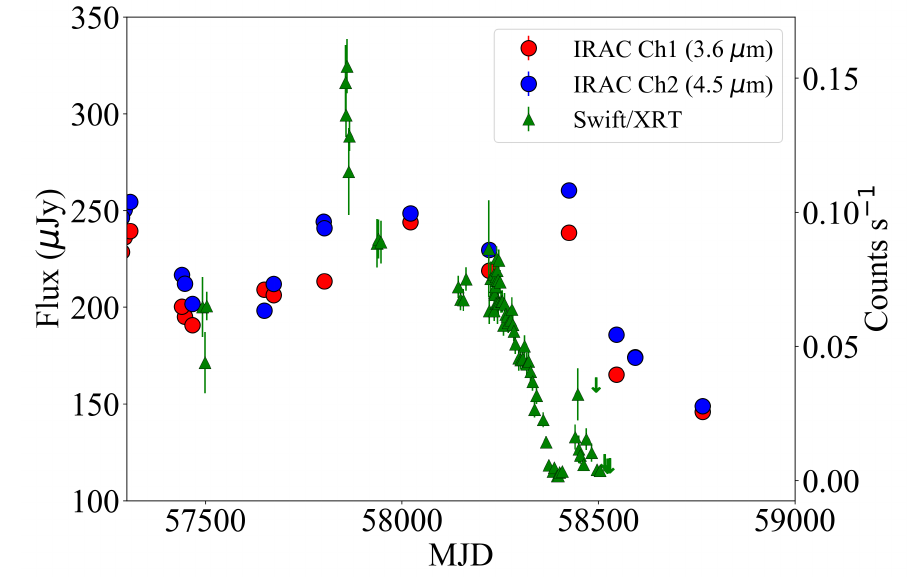
Figure 10. Mid-IR and X-ray light curve of SN 2010da/NGC 300 ULX-1 taken between MJD 57300 and MJD 58770 by Spitzer /IRAC and Swift /XRT, respectively. This figure is modified from Lau et al.